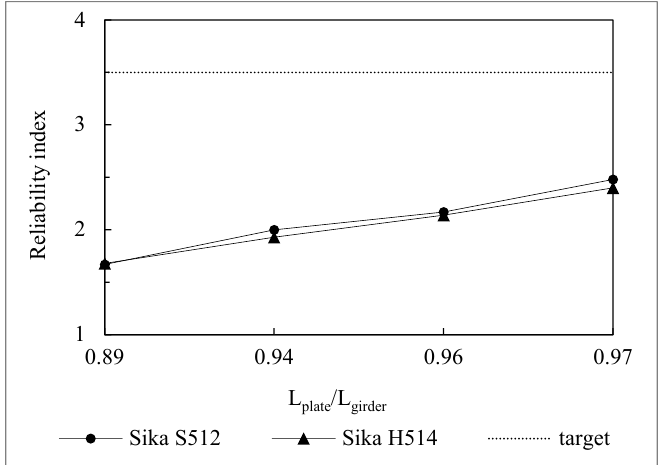
Figure 9. Reliability indices of debonding limit state for the different length ratios.